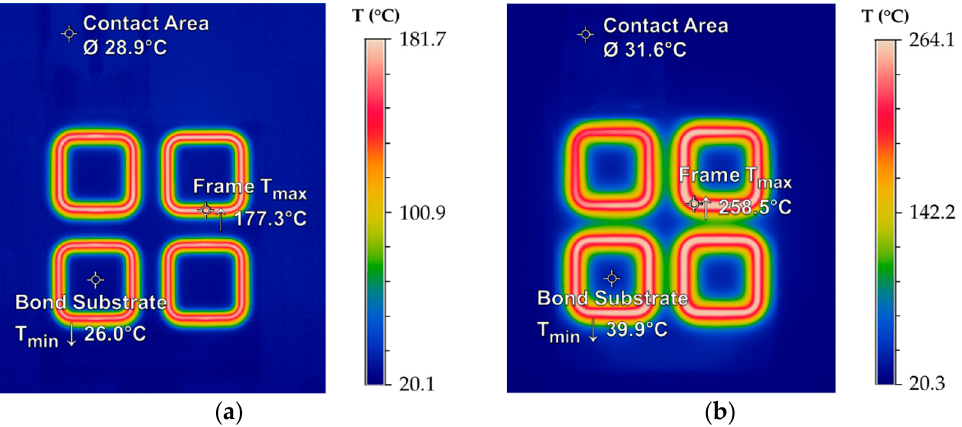
Figure 20. IR images of the localized inductive Cu-Sn heating for I 0 = 51.8 A and f 0 = 1.958 MHz: ( a ) Temperature distribution after t h = 1 s; ( b ) Temperature distribution after t h = 10 s.